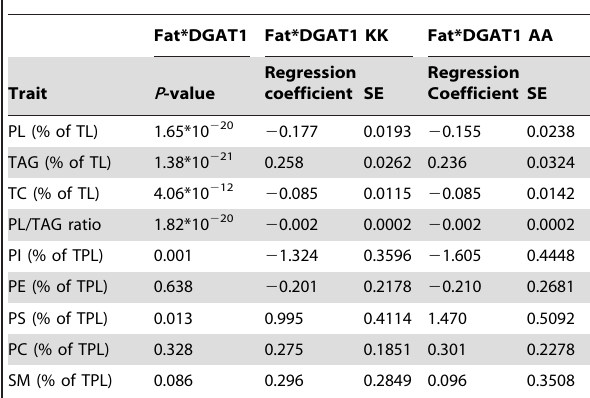
Table 2. Effect of the interaction between fat content and DGAT1 genotype on triacylglycerol content and on phospholipid content and